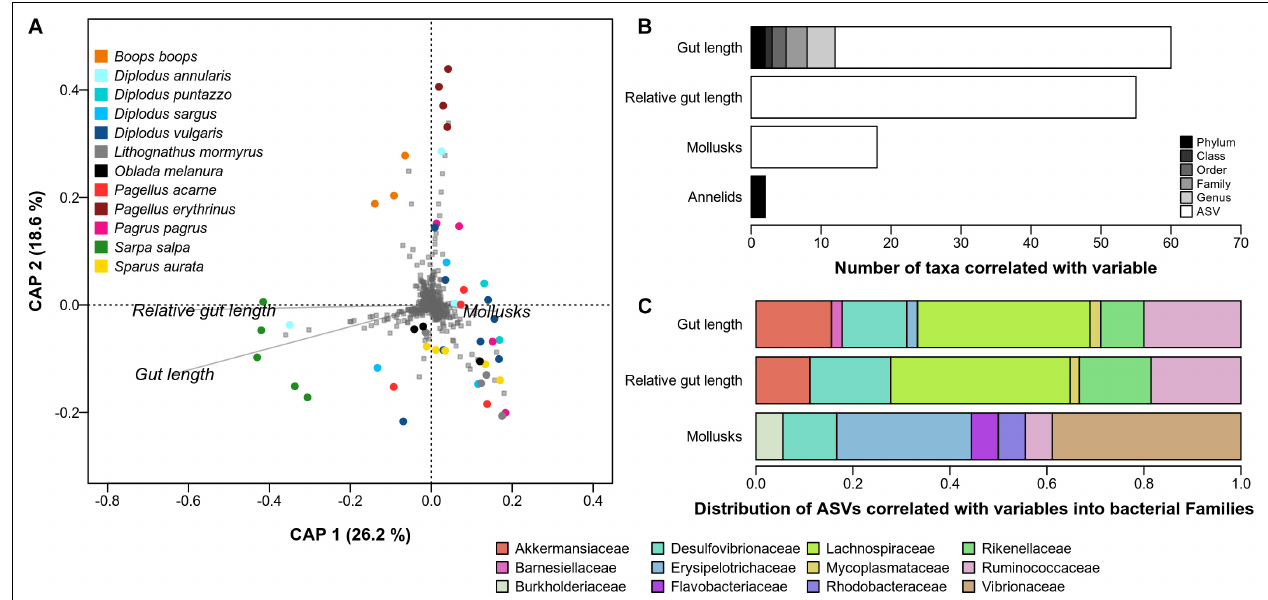
FIGURE 3 | Association between microbiome, gut morphological traits and diet items in Sparidae. (A) Constrained analysis on principal coordinates (CAP) analysis. Fish individuals are represented by colored dots, gut traits and diet items are represented by italicized labels and arrows, bacterial ASVs are represented by gray squares. Dissimilarity between microbiomes was estimated using abundance-weighted taxonomic dissimilarity (Hill diversity with q = 1). Only the variables identified as explaining a significant proportion of total microbiome variation are depicted (ANOVA.CCA, p -value < 0.05). (B) Number of taxa whose abundance are significantly correlated with variables that explained a significant proportion of microbiome variation. ASVs correspond to panel (A) while other ranks correspond to plots in Supplementary Figure 4 . (C) The ASVs associated with explaining variables (white bars in panel B ) were taxonomically assigned at the Family level and their proportion were